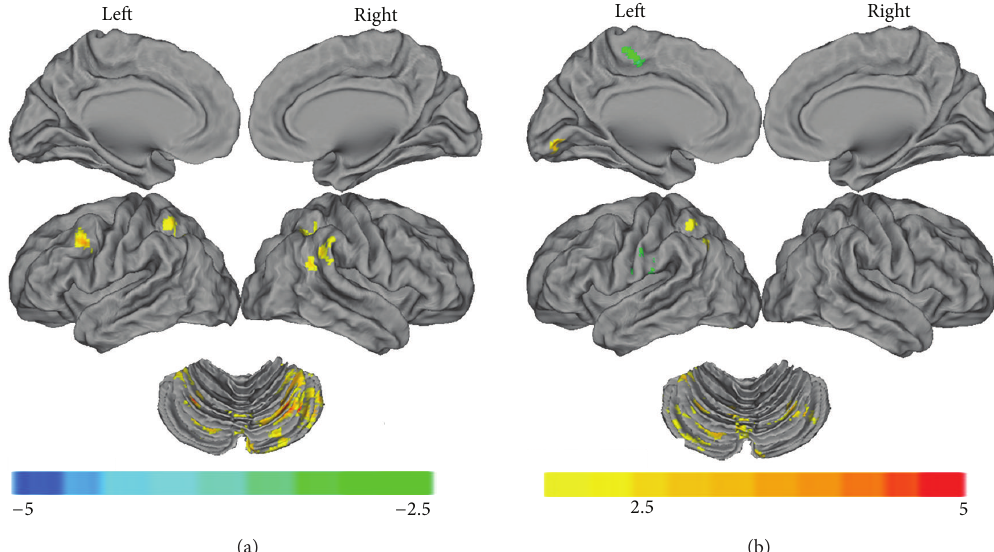
Figure 1: The anatomical distribution of the alterations in functional connectivity with the left primary visual cortex (a) and the right primary visual cortex (b)in anisometropic amblyopia are shown in comparison with normal sighted controls, as individually visualized using theCaret = 0.01 ). A detailed introduction of the brain regions can be found in Tables v5.61 software ( 𝑃 < 0.01 , 130 voxels, AlphaSim corrected 𝑃 alpha S2 and S3.